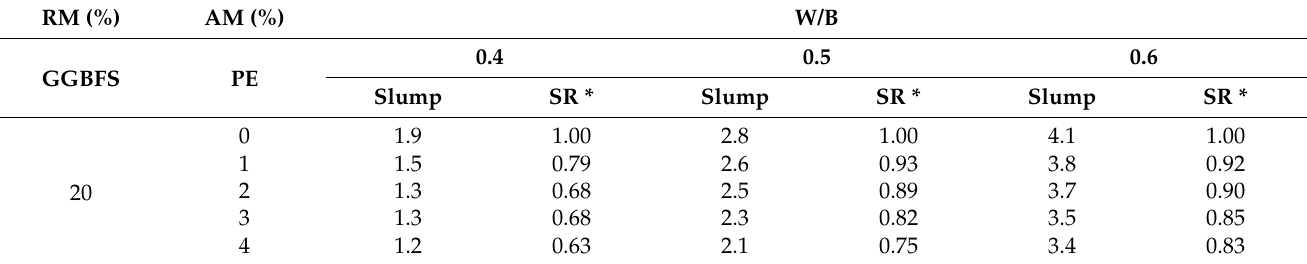
Table 4. Slump and slump ratio of cement mortar with different W/B ratios and waste PE (unit: cm).